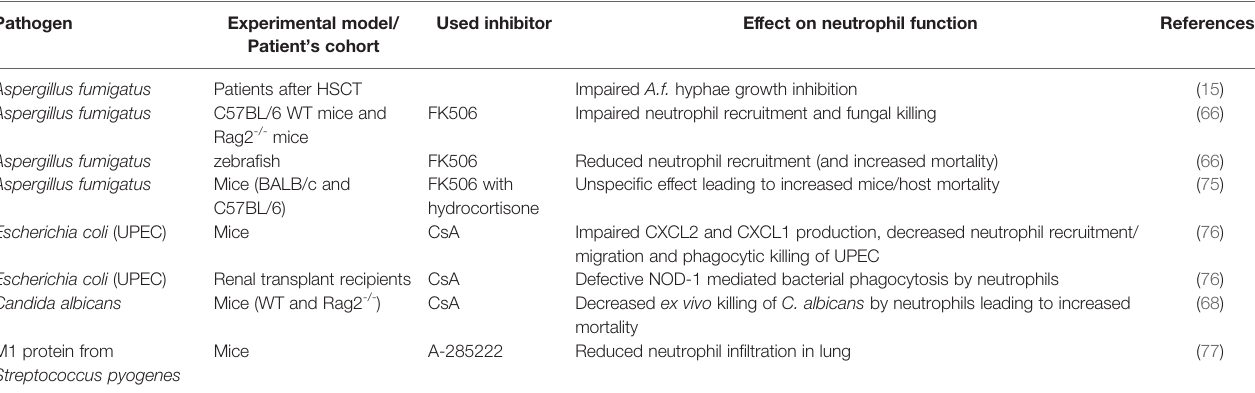
TABLE 2 | Impact of impaired calcineurin-NFAT signaling on neutrophil functions during infection.